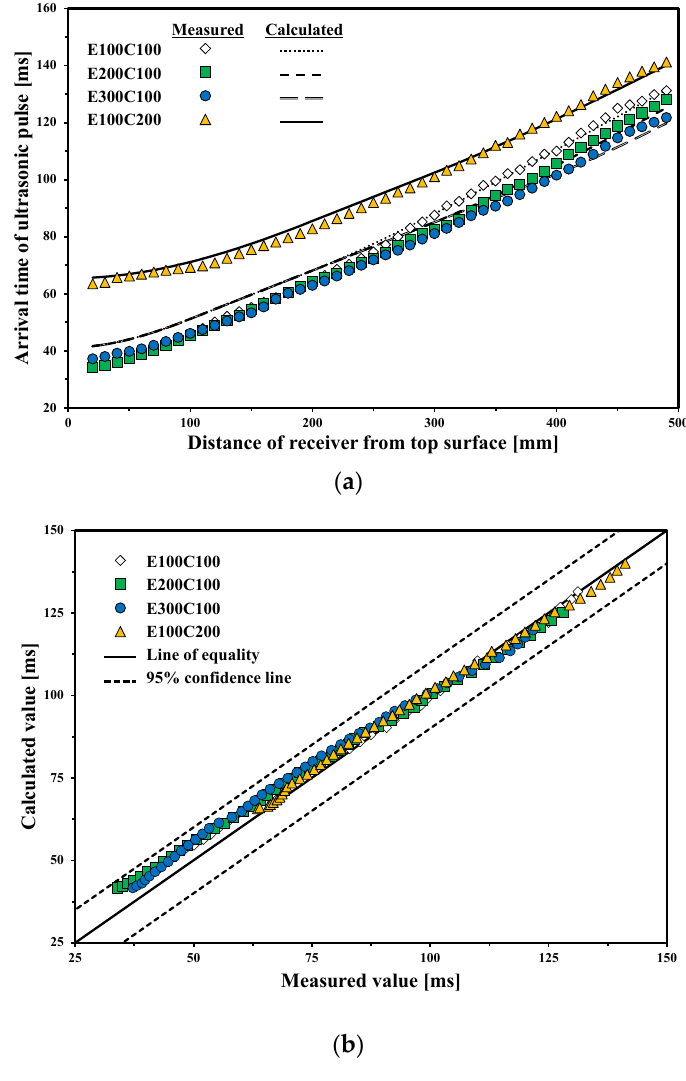
Figure 10. Arrival time of ultrasonic pulse in the specimen with the different embedment lengths of the anchor bolt and cover thicknesses: ( a ) the variation in arrival time of the ultrasonic pulse according to the distance of the receiver from the top surface; and ( b ) the measured value vs. calculated value.